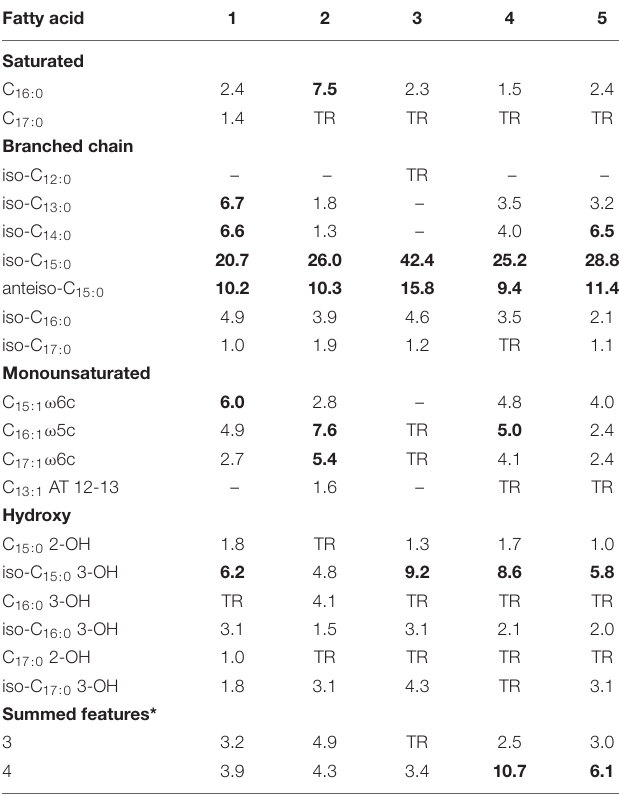
TABLE 2 | Cellular fatty acid contents (%) of strain N1Y132 T and the related Carboxylicivirga species.